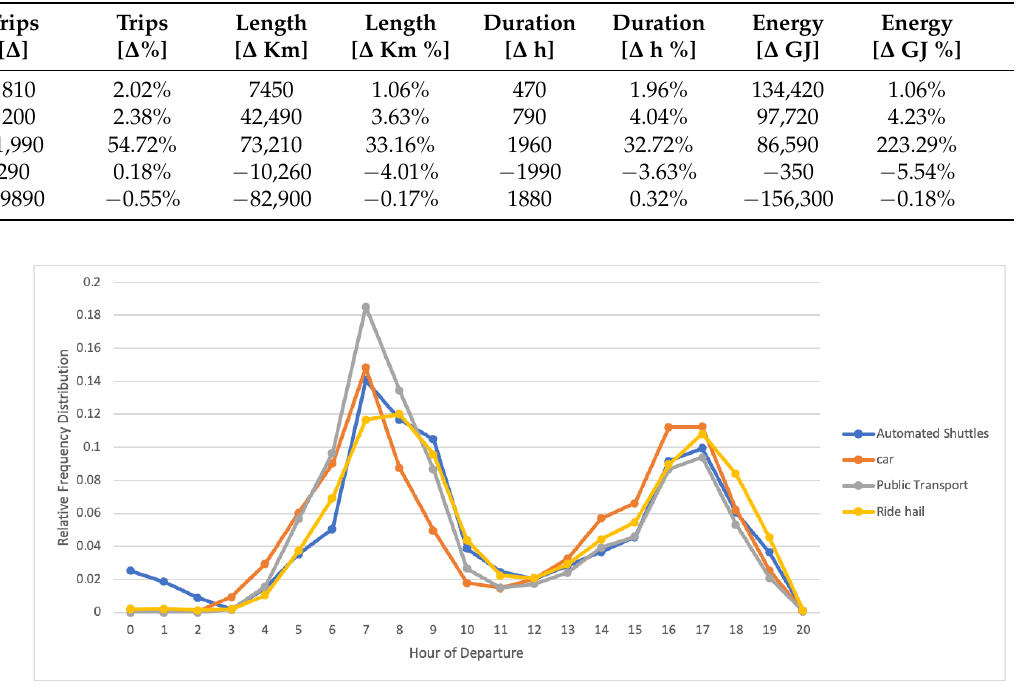
Table 6. Statistics of trips involving Santa Clara County: differences between the baseline and the developing scenario per fuel type—interfered to the population.